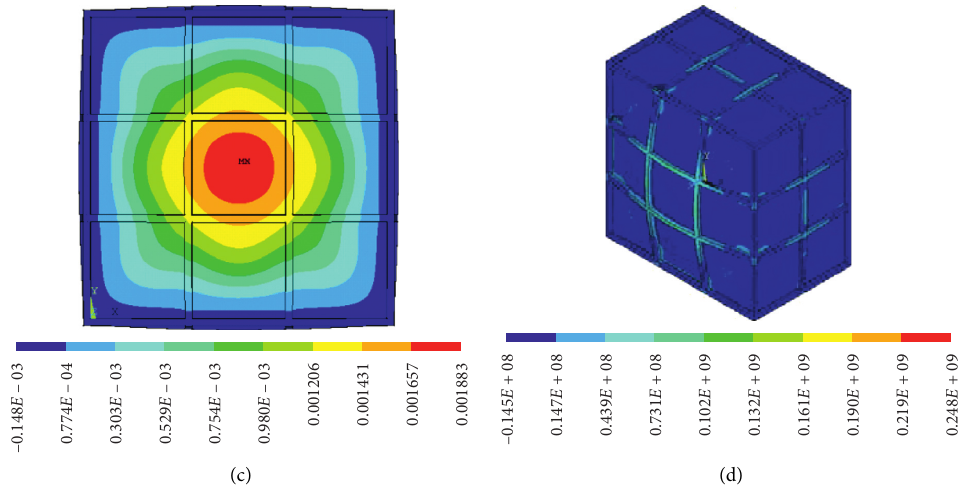
Figure 8: Distribution of (a) the displacement in the (x) direction; (b) the displacement in the (y) direction; (c) the displacement in the (z) direction; (d) stress of the model box.